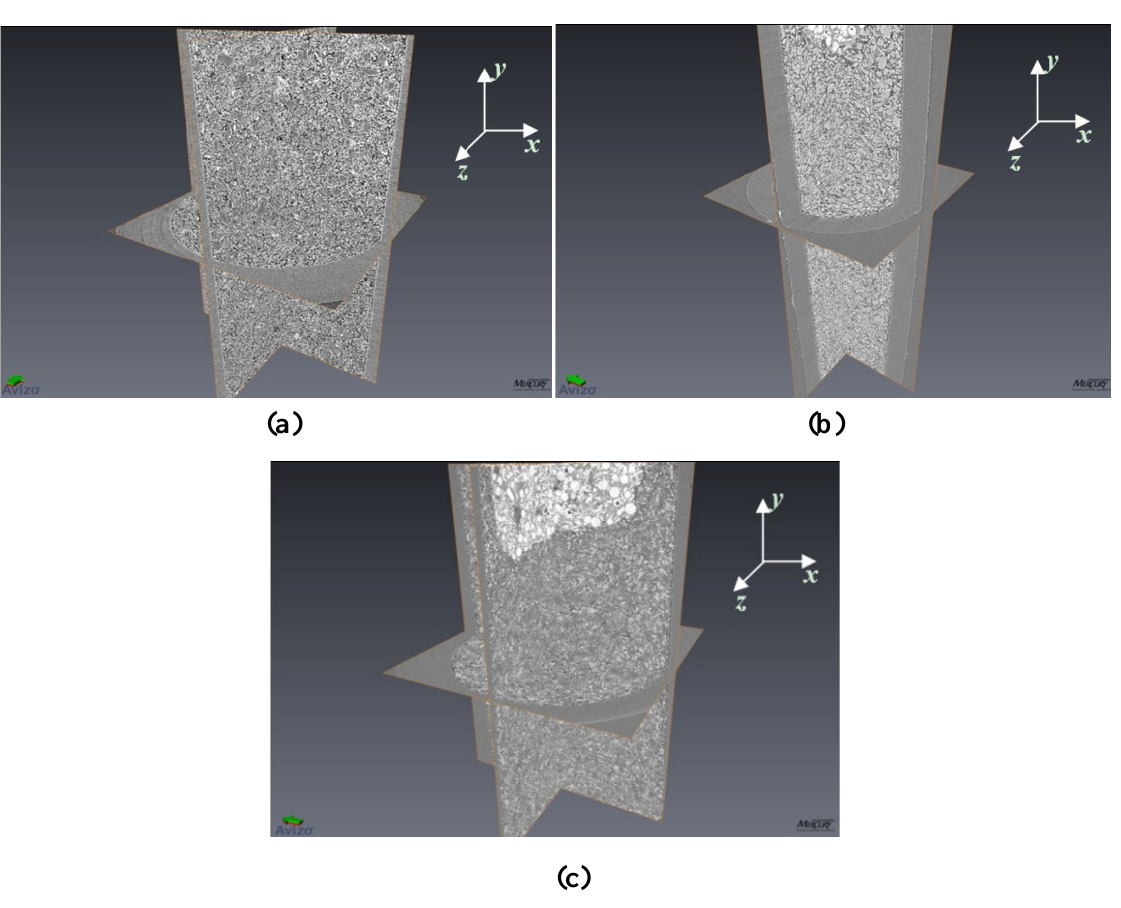
catalyzed LiBH ; ( b ) 4 mol % 3 4 catalyzed LiBH :MgH in 1:1 molar 3 4 2